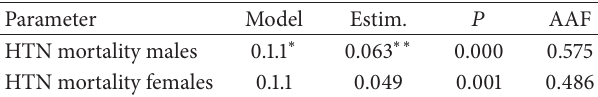
Table 2: Estimated effects (bivariate ARIMA model) of overall alcohol consumption on IHD mortality